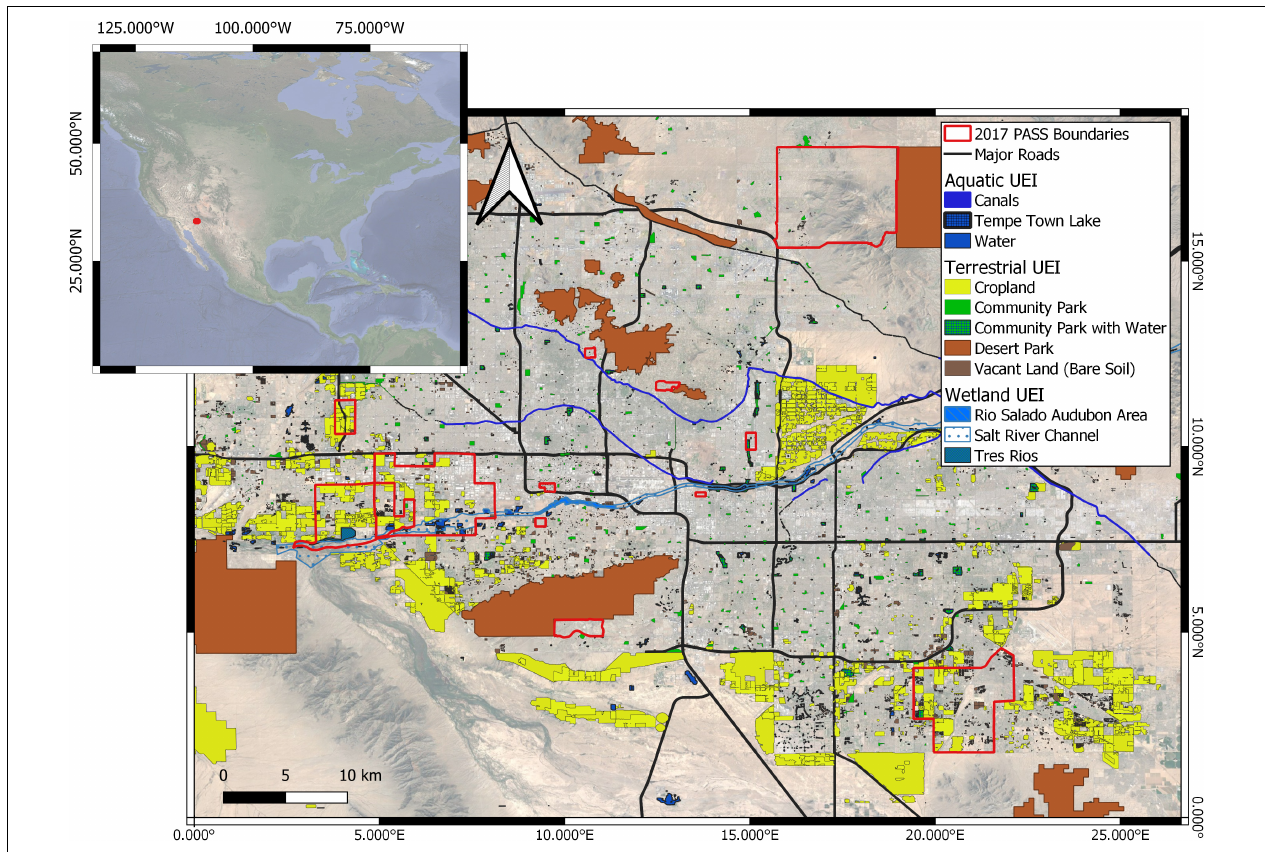
FIGURE 1 | The Phoenix study area (indicated in red on the map of North America). PASS neighborhoods outlined in red. Aquatic, terrestrial, and wetland UEI are shown throughout the study area. Base maps are from Google Earth